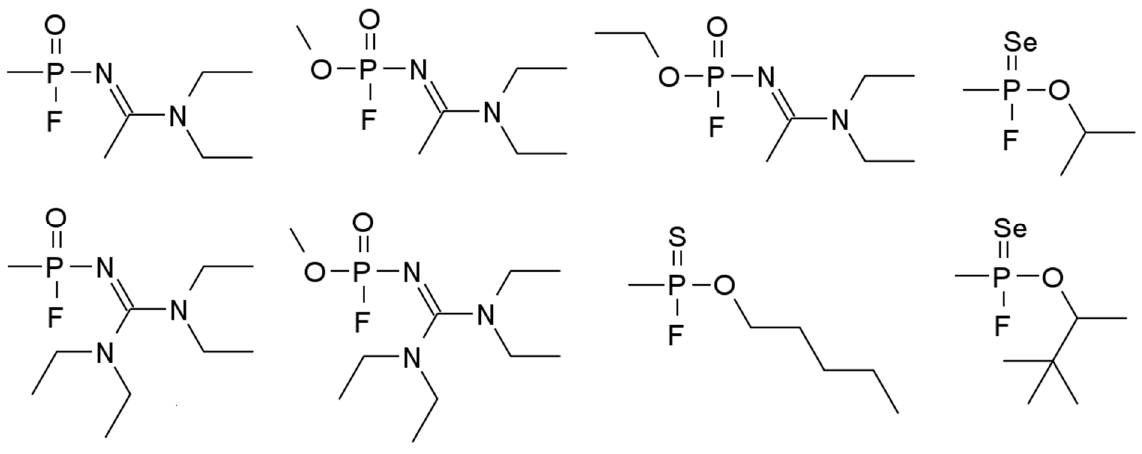
Figure 6. Selected structural formulas of the known Novichoks [75]